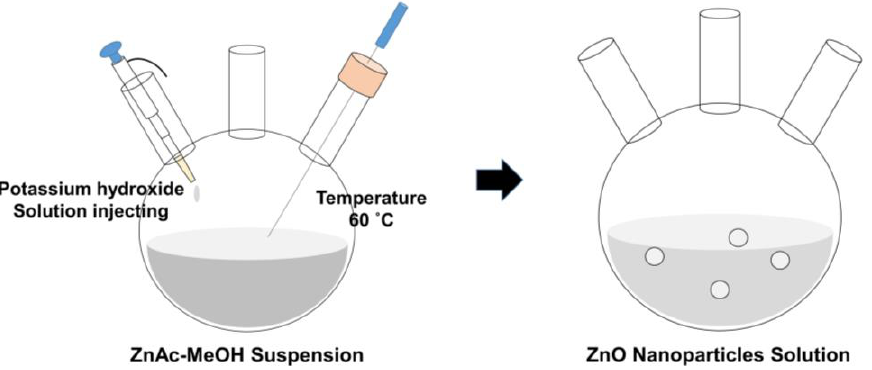
Figure 2. Schematic diagram of ZnO nanoparticle synthesis